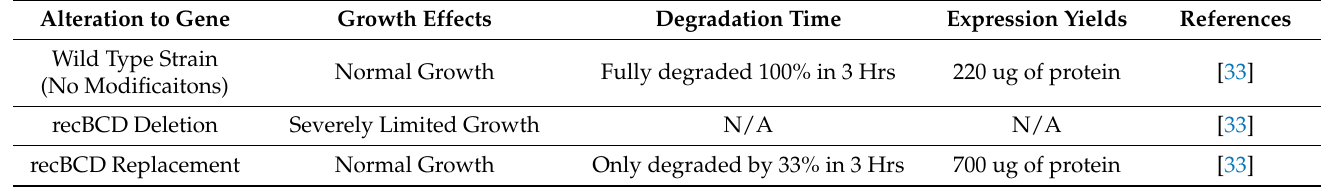
Table 2. Growth effects and LET stability of recBCD mutant strains in comparison to the Wild Type.